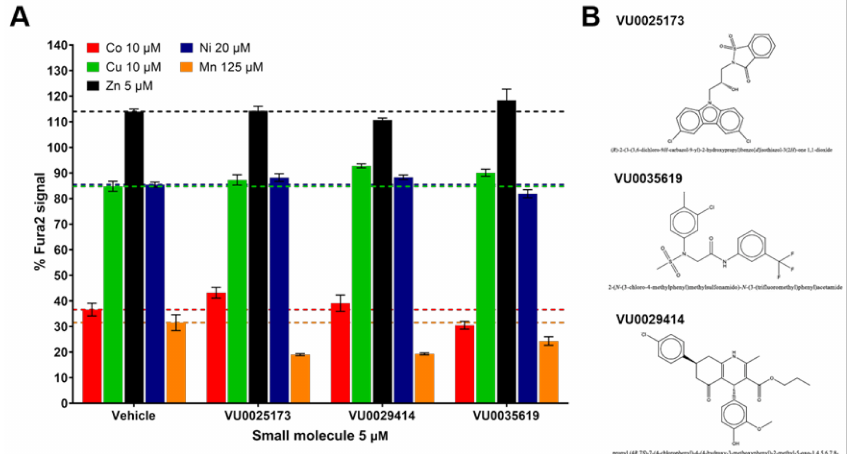
Figure 4. The profiles of the Mn-selective small molecules VU0025173, VU0035619, and VU0029414. Q7 cells were exposed in HBSS with DMSO vehicle or small molecules (5 µ M) with a single divalent metal (Co 10 µ M; Cu 10 µ M; Zn 5 µ M; Ni 20 µ M; or Mn 125 µ M) for 2 h at 37 ◦ C. Following the exposure, cells were washed with PBS and lysed open with PBS + 0.1% Triton for CFXEA. ( A ) shows the %Fura-2 signal of CFXEA with means ± standard deviations. For ease of visualization a colored dashed line is shown at the %Fura-2 signal of the vehicle control for each metal. ( B ) shows the chemical structures of the